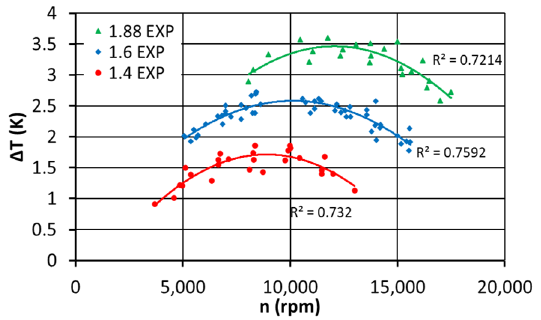
Figure 15. Temperature drop in the turbine from the